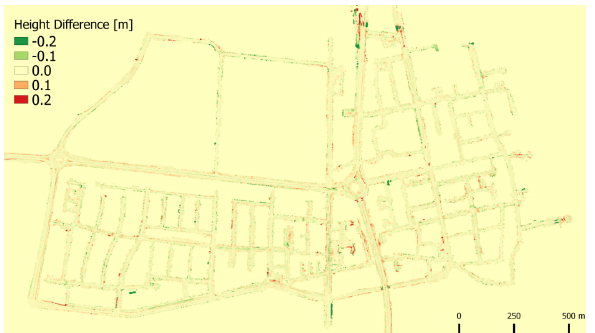
Figure 12. Difference between mobile mapping DTM+ and